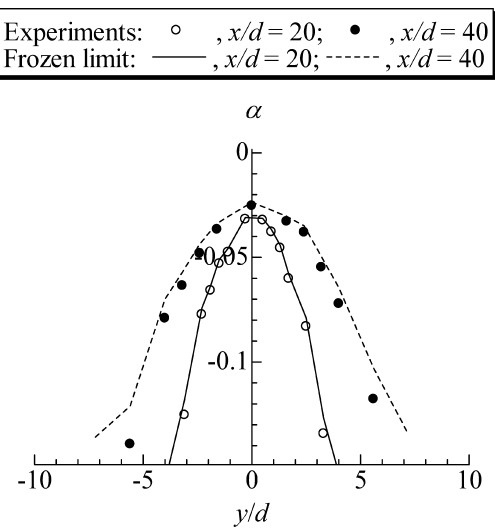
Fig. 9 Cross-streamwise profiles of segregation coe ffi cient of species R and